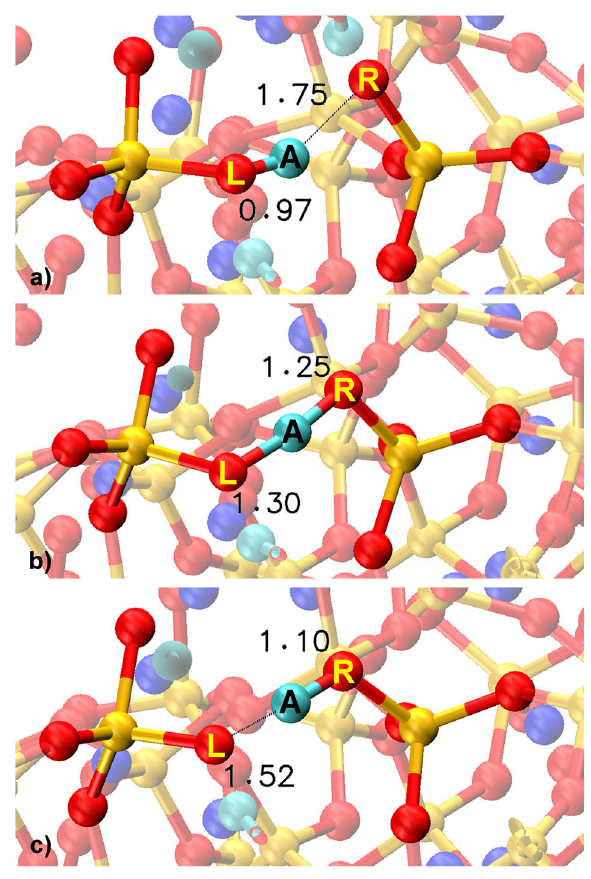
Fig. 7 Proton transfer in the adjacent-exchange silanol re- formation process between two [SiO 4 ] tetrahedron units. a Silanol group (left, Si – O L H A ) and NBO − (right, O R ), b hydrogen (H A ) shared by two silanol groups, c NBO − (left, O L ) and silanol group (right, Si – O R H A